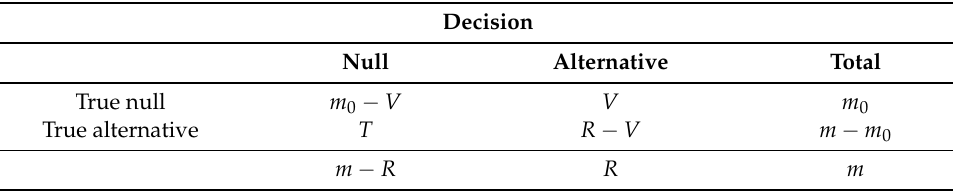
Table 9. Confusion matrix when testing m hypotheses